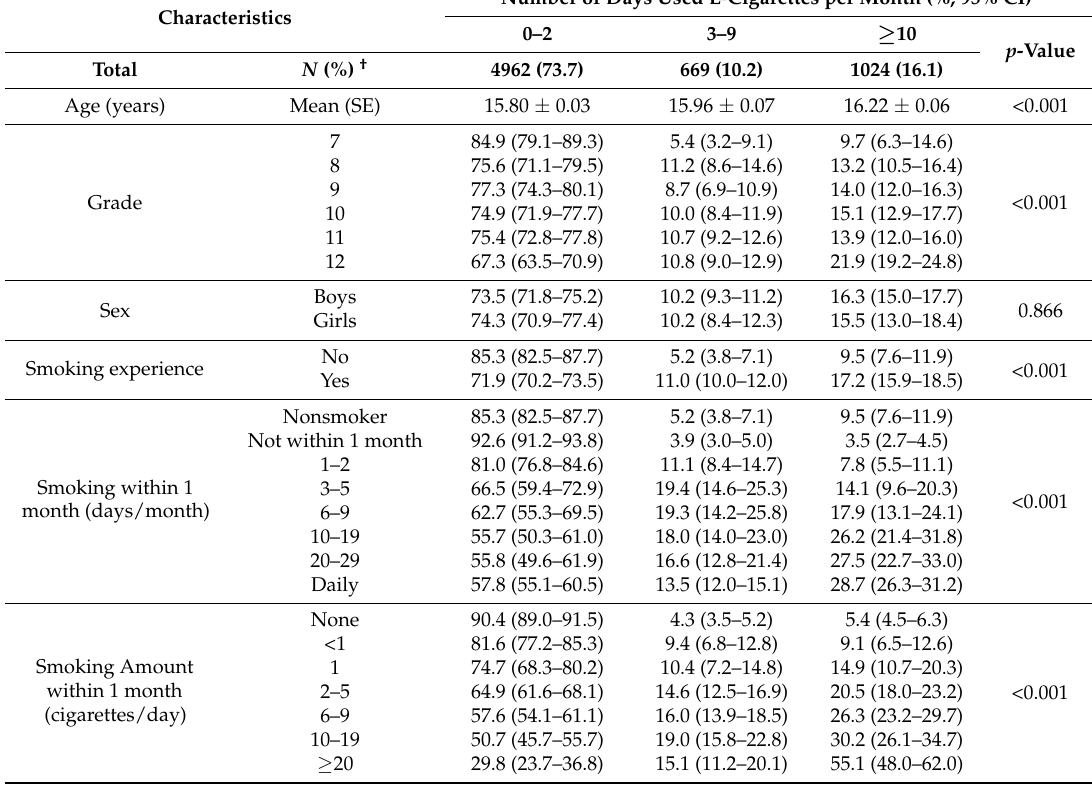
Table 2. Frequency of e-cigarette use according to smoking behaviors among ever e-cigarette users of Korean adolescents ( N =